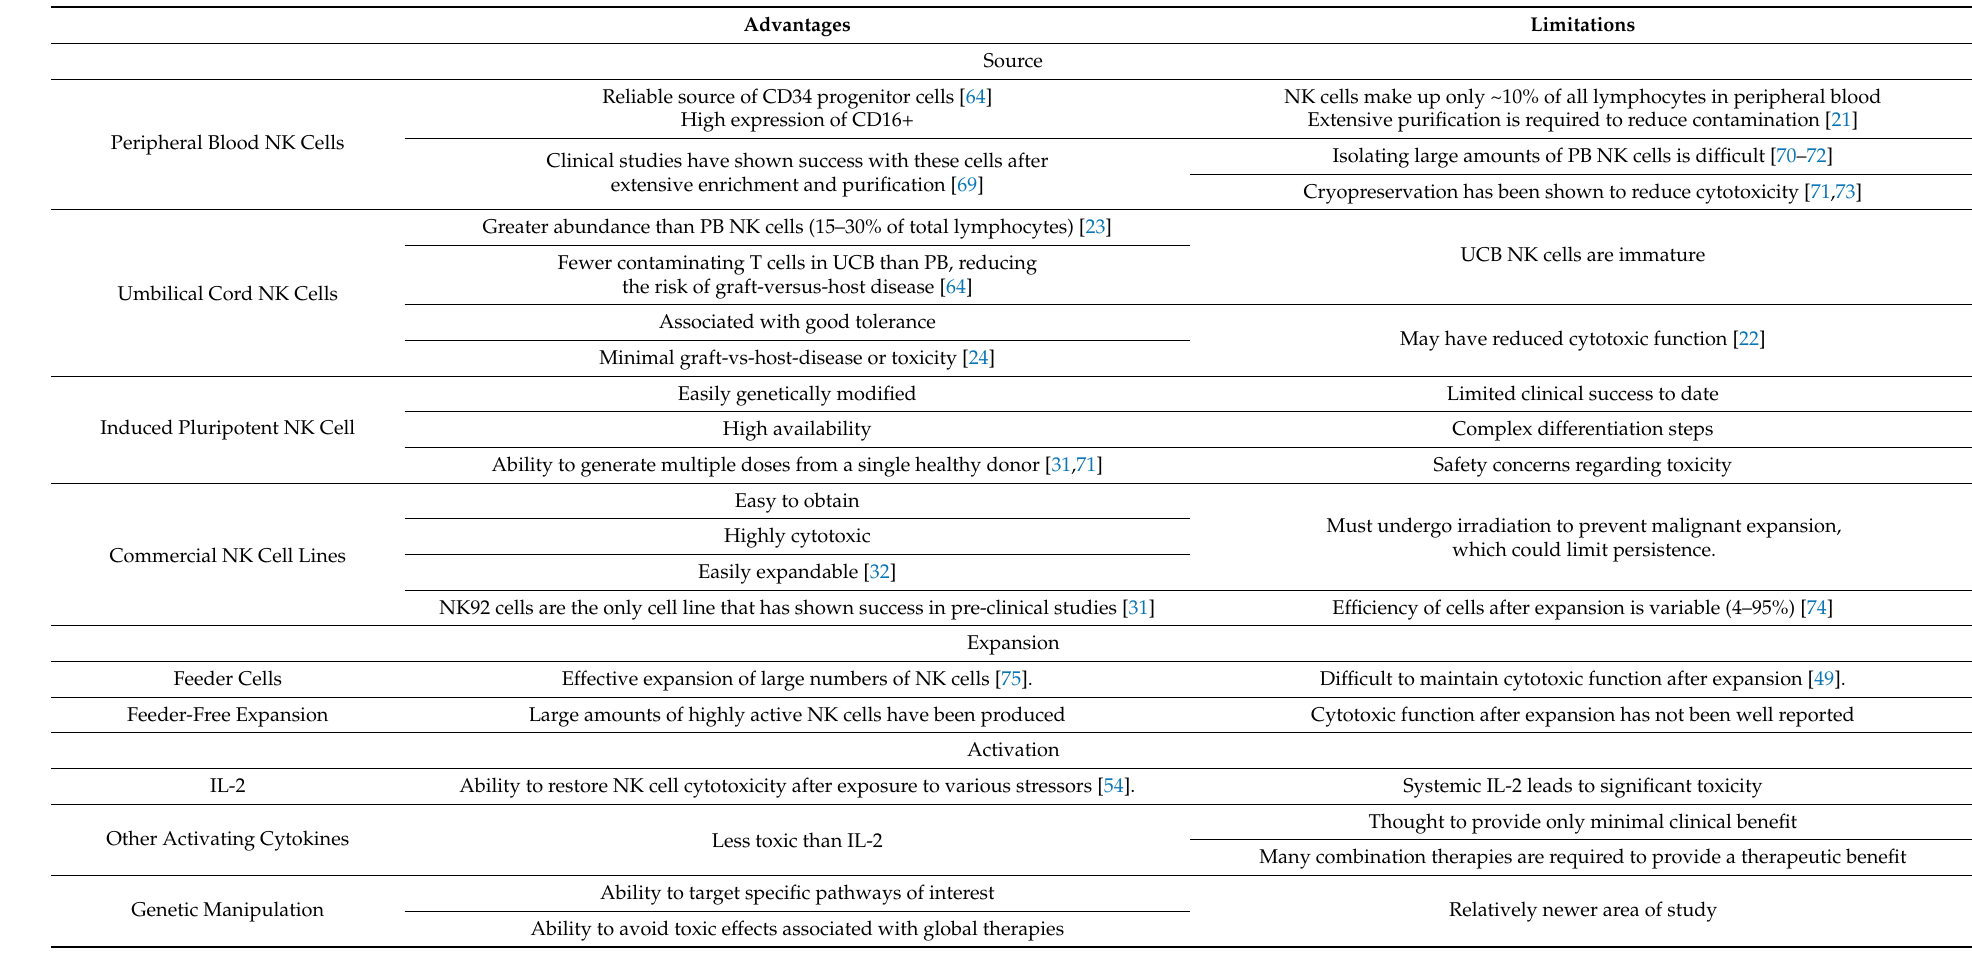
Table 1. Advantages and Limitations to Current NK Cell